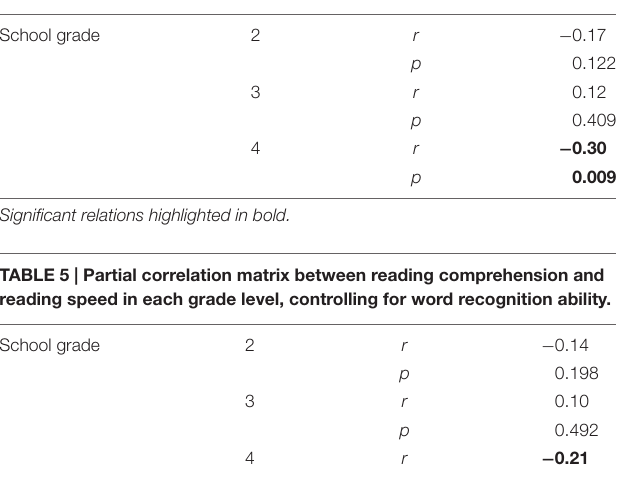
TABLE 4 | Correlation matrix between reading comprehension and reading speed in each grade level.